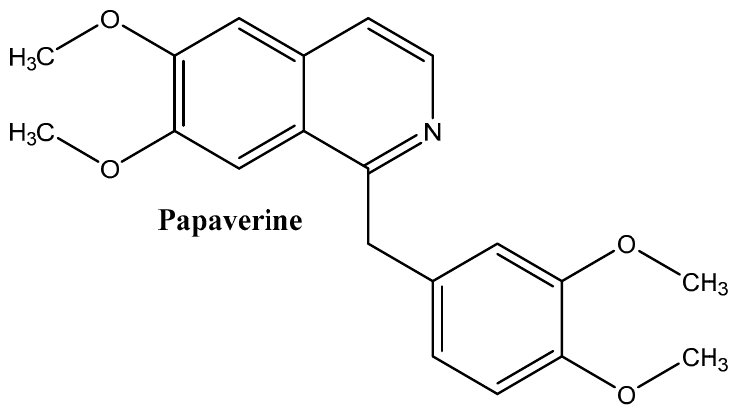
Figure 1. Chemical structure of papaverine.